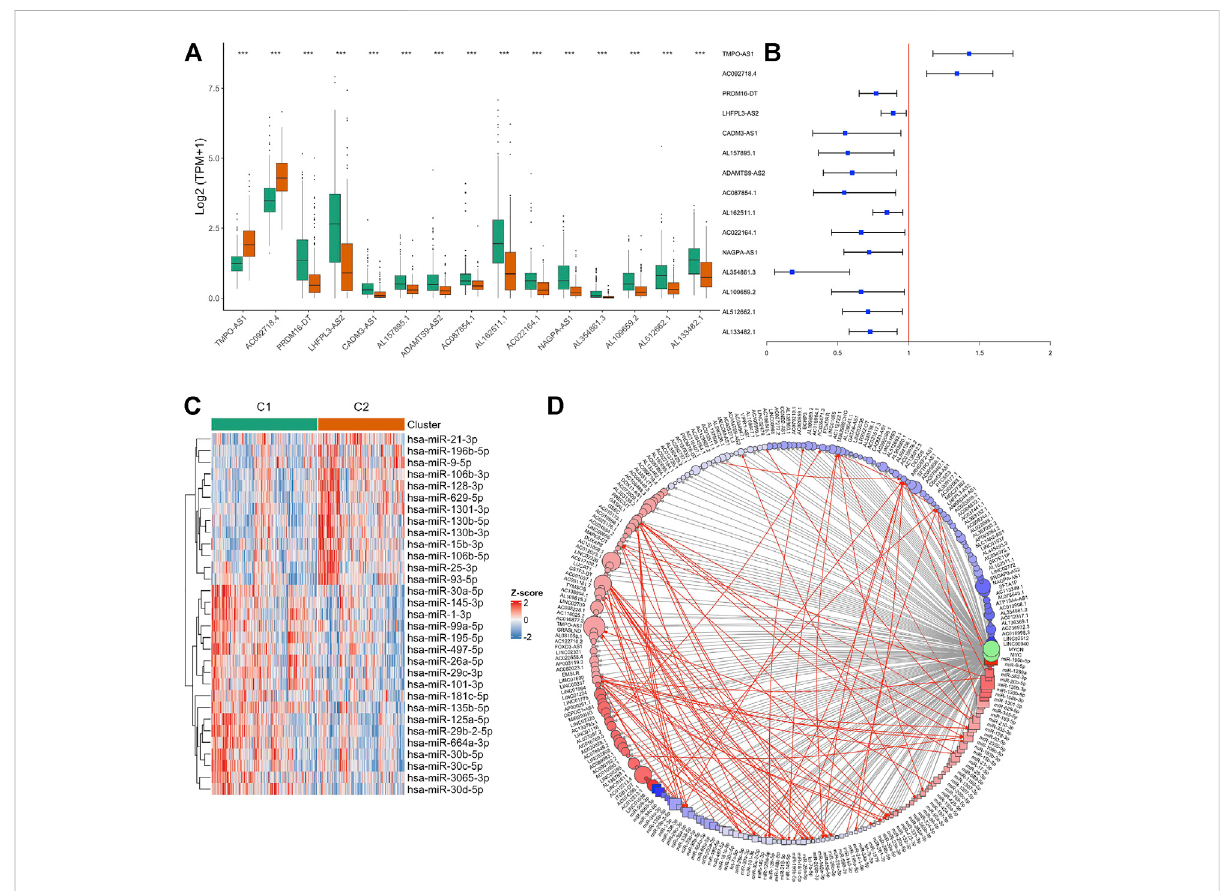
FIGURE 6 Identi fi cation of non-coding RNA associated with MYC signaling. (A) lncRNAs differentially expressed between the C1 and C2 groups. (B) Univariate Cox analysis revealed the relationship between these lncRNAs and prognosis. (C) miRNAs differentially expressed between the C1 and C2groups. (D) ConstructionofCeRNAnetworksassociated toMYC signaling.Theresultinglog2FC andadj. p valuewereusedas thecolorsand sizes of the nodes in the subsequent network graph drawing, respectively. Circle represents lncRNA, and square represents miRNA.Gray lines represent all possible interactions between ncRNA and MYC/MYCN, and red lines indicate possible interactions between